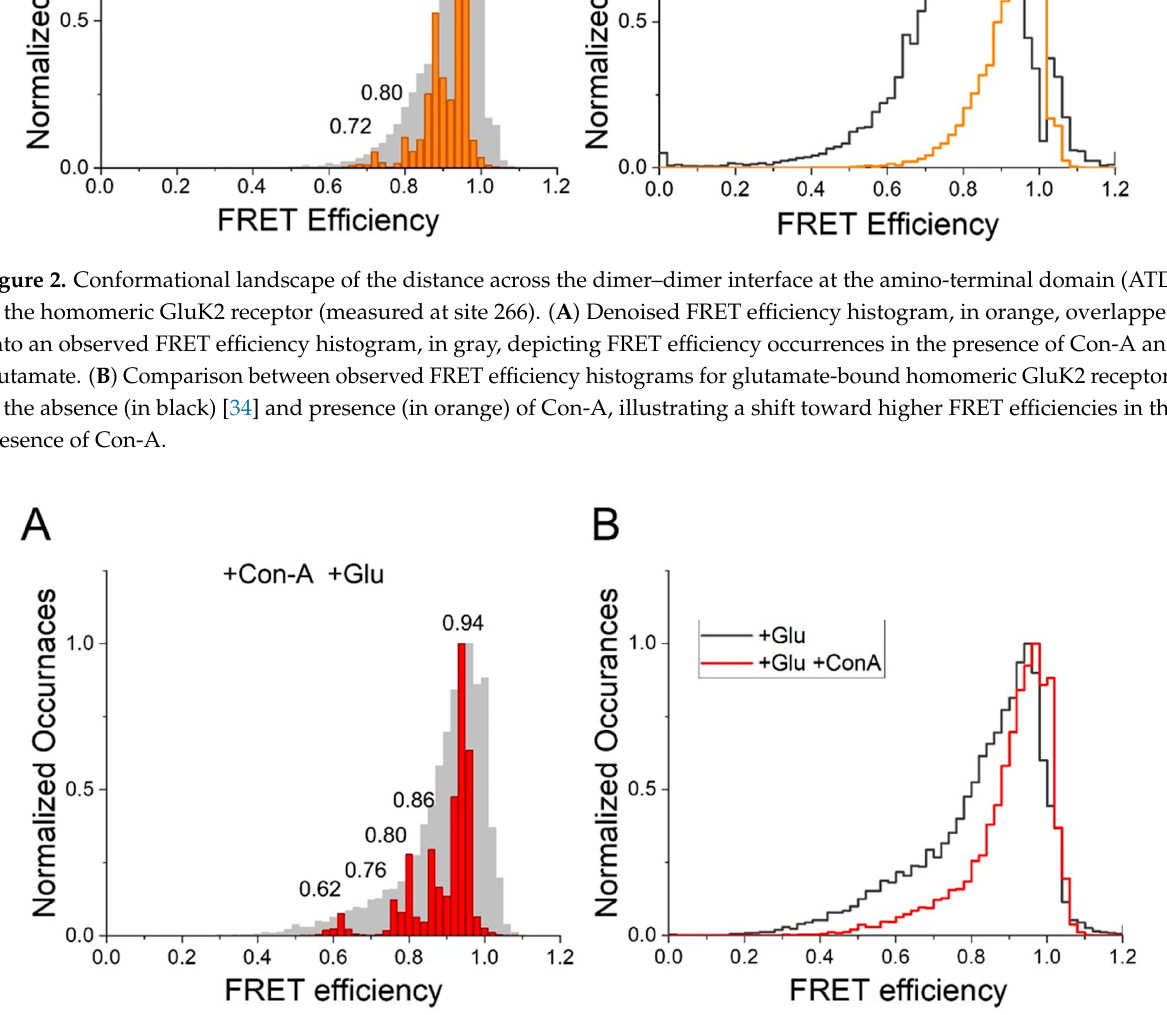
Figure 3. Conformational landscape of the distance between subunits at the dimer interface of the agonist-binding domain (ABD) of a homomeric GluK2 receptor (measured at site 479). ( A ) Denoised FRET efficiency histogram, in red, overlapped over observed FRET efficiency histogram, in gray, depicting FRET efficiency occurrences in the presence of Con-A and glutamate. ( B ) Comparison between observed FRET efficiency histograms of glutamate-bound homomeric GluK2 receptors in the absence (in black) [34] and presence (in red) of Con-A, illustrating a decrease in the low-FRET efficiency population in the presence of Con-A.